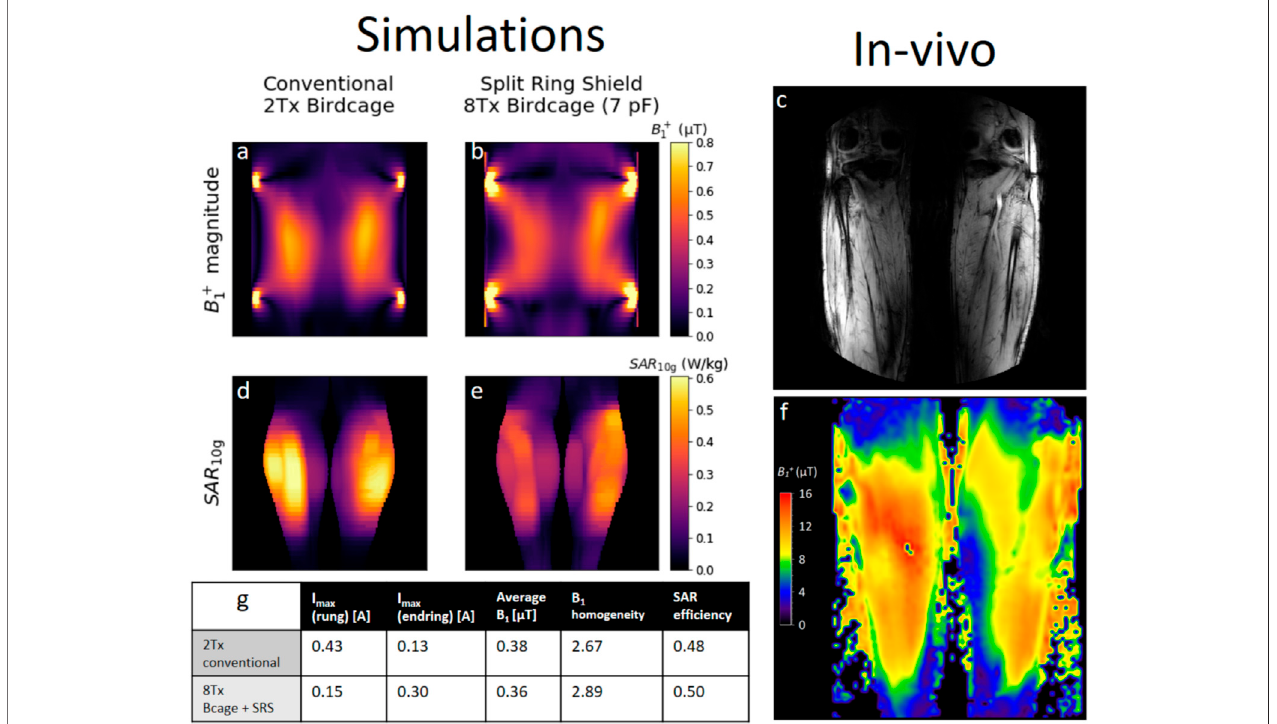
FIGURE 10 | Overview of results obtained using 8Tx birdcage with SRS. Left: simulated B 1 distributions (A,B) and 10-g averaged SAR distributions (D,E) comparing the 8Tx birdcage with SRS to a conventional 2Tx birdcage with PEC shield. (G) Table summarizing metrics computed from simulated fi elds. All simulated fi elds are normalized to 1 W accepted power. Right: In-vivo results obtained using 8Tx birdcage with SRS. (C) Anatomical image. (F) DREAM-B 1,257 W of accepted power.